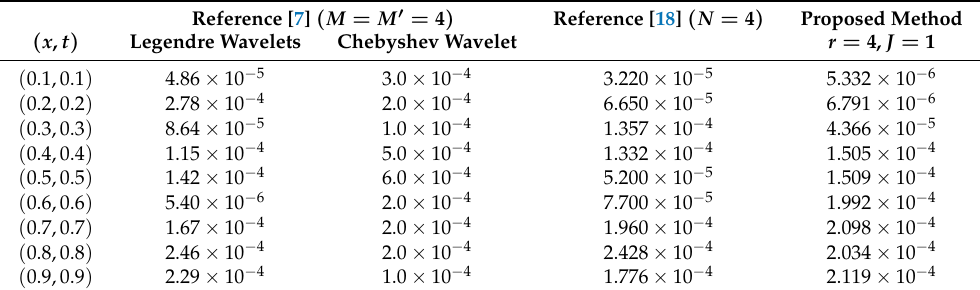
Table 3. Absolute values of the error at the selected points taking θ = 1/2 and δ t = 0.1/2 9 for